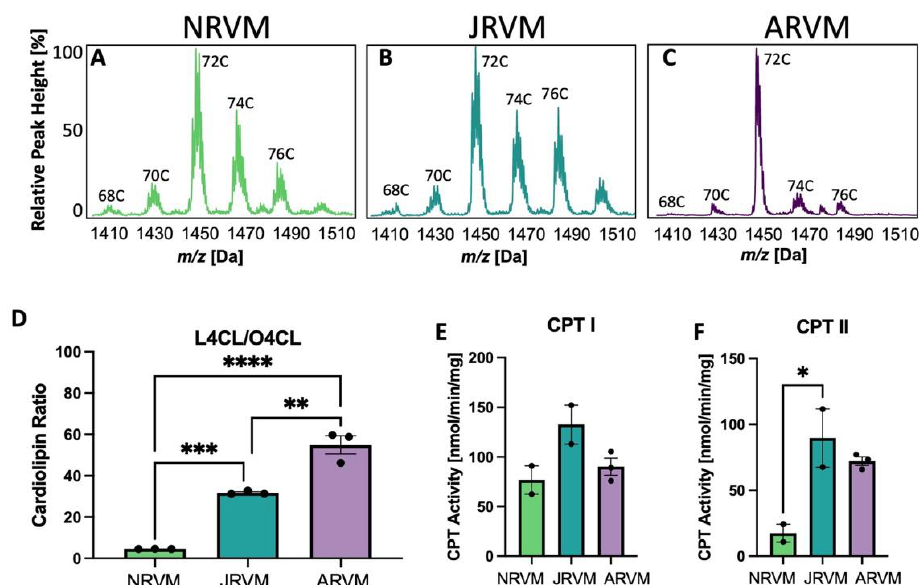
Figure 4. CL and CPT changes in primary cultured rat heart cells. ( A – C ) CL spectra in heart and liver from neonatal ( A ), juvenile ( B ), or adult ( C ) rat ventricular myocytes (NRVM, JRVM, ARVM, respectively). C indicates the total number of side chain carbons on the CL in ( A – C ). ( D )The ratio of L 4 CL to O 4 CL in these cells; ( E , F ) CPT I and II activity in these cells. * p < 0.05, ** p < 0.01, *** p < 0.001, **** p < 0.0001. In ( D – F ), N = 2-3; error bars represent standard error of the mean.